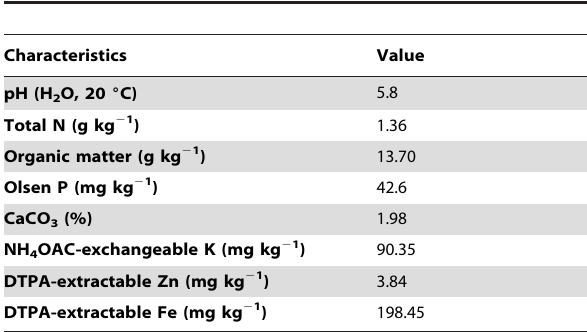
Table 1. Selected physical and chemical properties of the